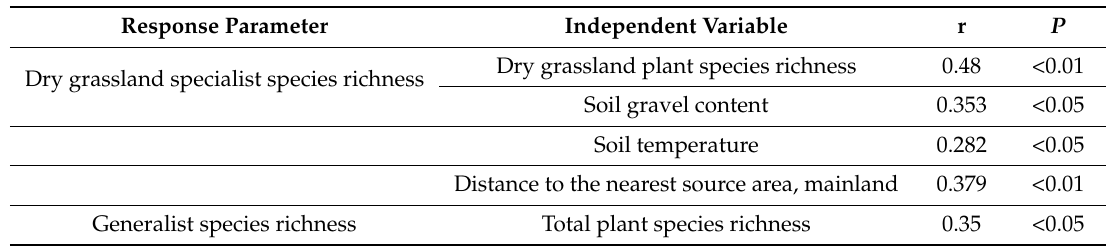
Table 3. Independent variables influencing springtail species richness in 50 dry grassland patches in eastern Austria.